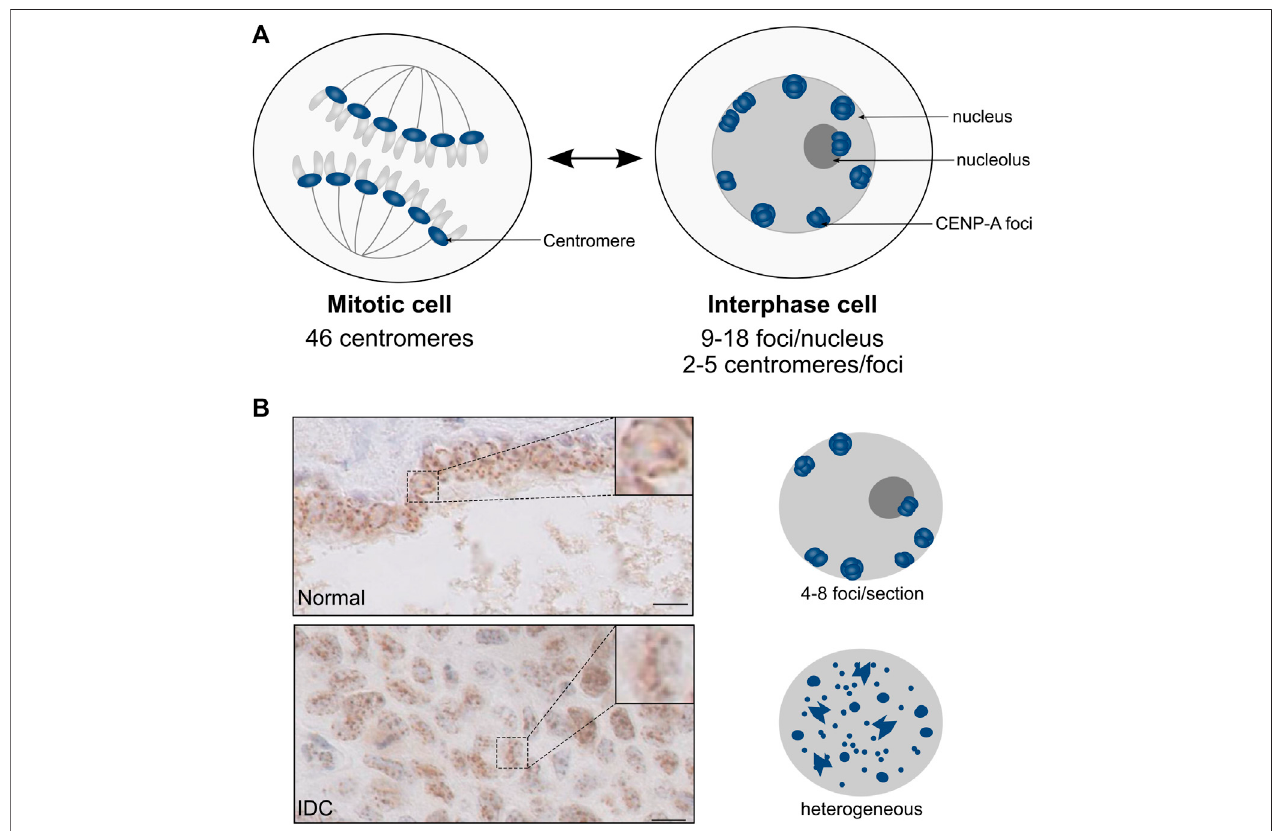
FIGURE 5 | CENP-A localization patterns in normal tissues and neoplastic lesions. Modi fi ed from Verrelle et al., 2021. (A) Schematic representation of nuclei from mitosis(left)andinterphase(right)cells.Ininterphasecells,theclusteringofcentromericCENP-A-enrichedregions(blue)givesrisetoCENP-Afociattheperiphery ofthe nucleusand,infewercases,ofthenucleolus. (B) CENP-AlocalizationpatternsvisualizedbyIHCinbreasttissues.Top:Normalduct;Bottom:InvasiveDuctalCarcinoma (IDC). The boxed area shows the magni fi cation of a representative nucleus. Scale bar = 10 µM. On the right is shown a schematic representation of the CENP-A localization pattern, with CENP-A foci (blue) within the nucleus